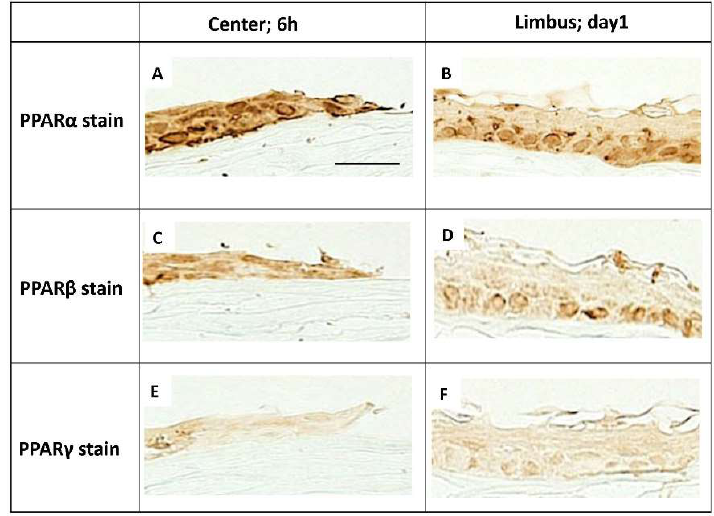
Figure 2. The expression of PPARs in epithelial cells in alkali-burned cornea. PPARα, β, and γ was expressed on re-epithelialized basement cells. In the epithelial basement cells of center at 6 h and limbus at day 1, the expression of PPARα ( A , B ) seemed to be more prominent than the expression of PPARβ ( C , D ) or PPARγ ( E , F ). Scale bar: 20 μm.